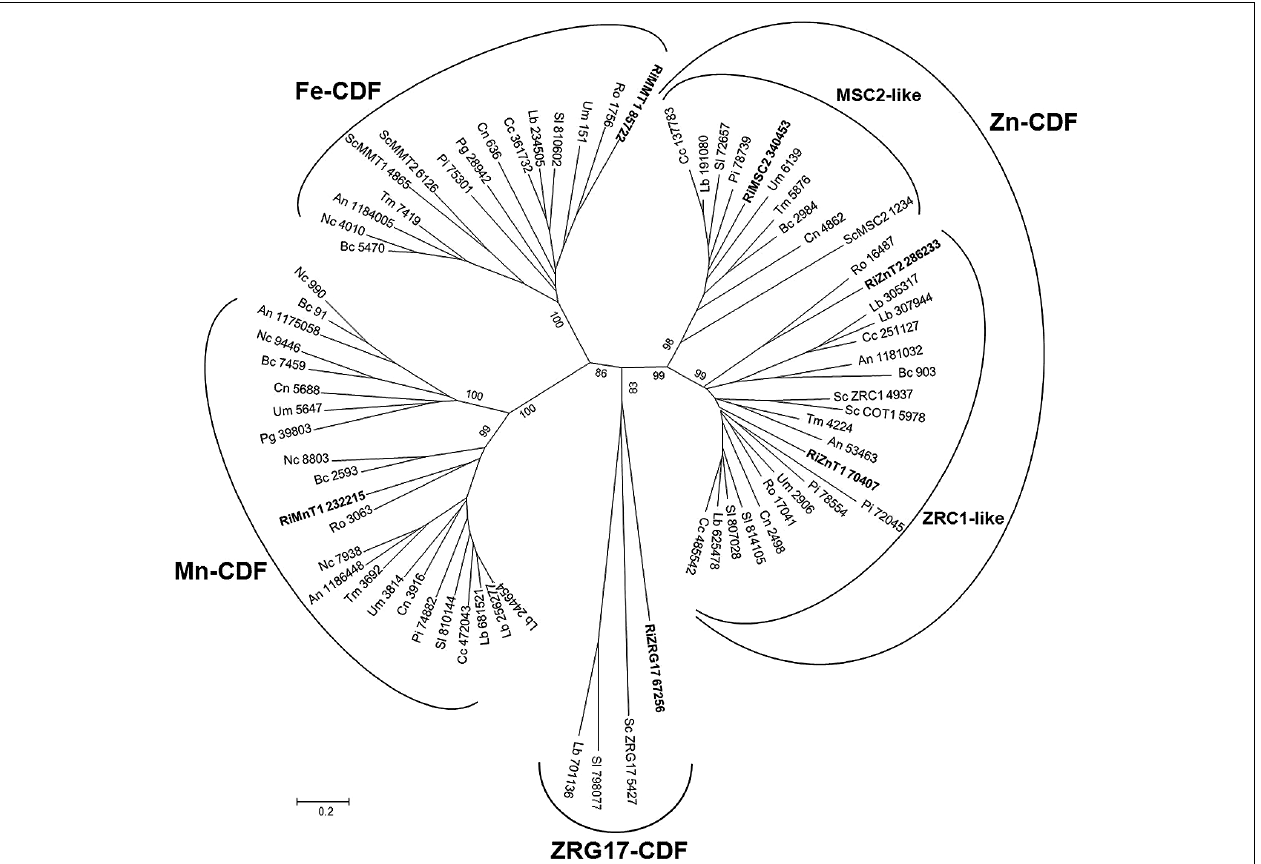
FIGURE 7 | Phylogenetic relationships of the Rhizophagus irregularis cation diffusion facilitators (CDFs) with homologous sequences from selected species representative of the major fungal phyla. The Neighbor-Joining tree was created with MEGA 6. Protein JGI identification numbers are indicated. R. irregularis genes are shown in bold. Organisms: An, Aspergillus niger ; Bc, Botrytis cinerea ;